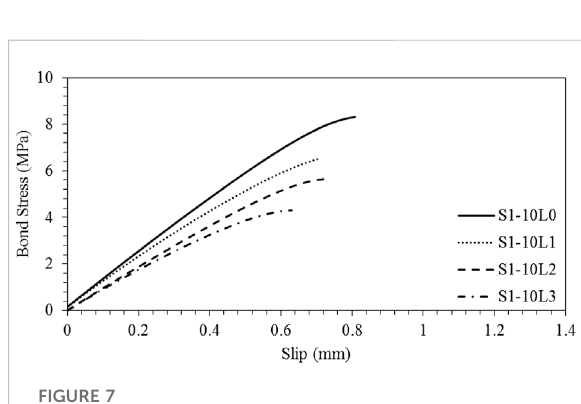
FIGURE 7 Relation between bond stress and slip for S1 strip and bond length of 100